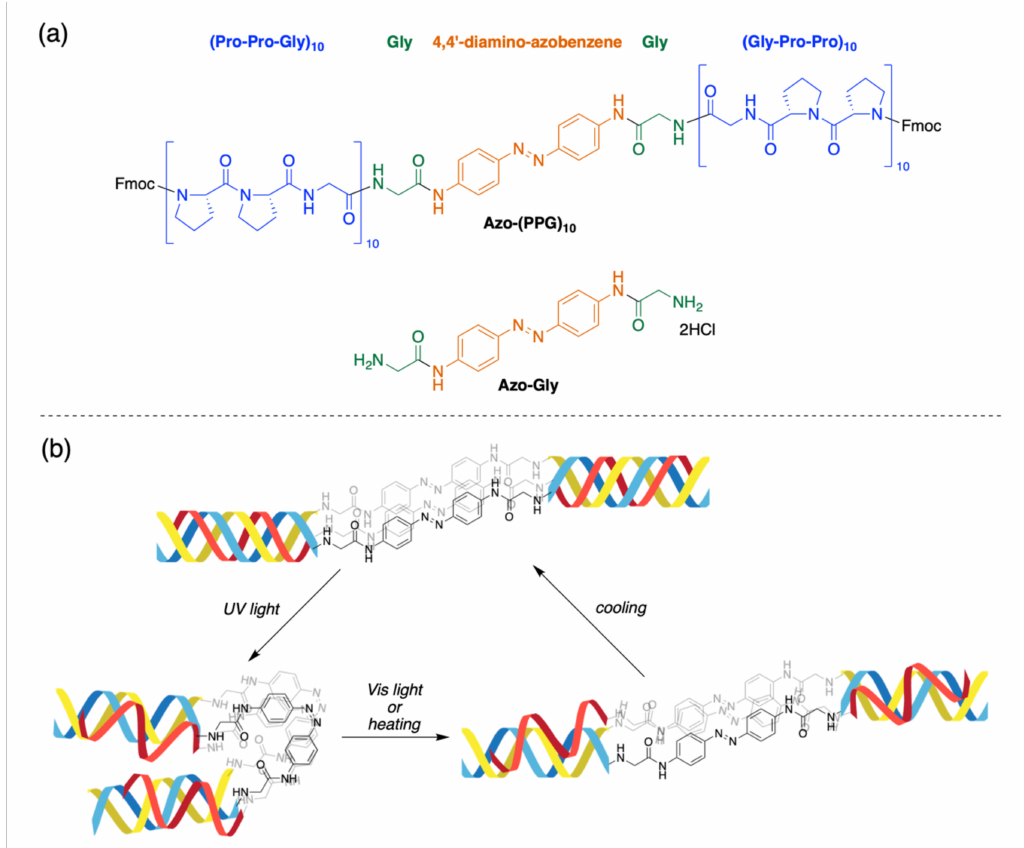
Figure 1. ( a ) Design of the light-responsive CMP Azo-(PPG) 10 and azobenzene linker unit Azo-Gly . ( b ) Expected mechanism for controlling the triple helical structure of Azo-(PPG) 10